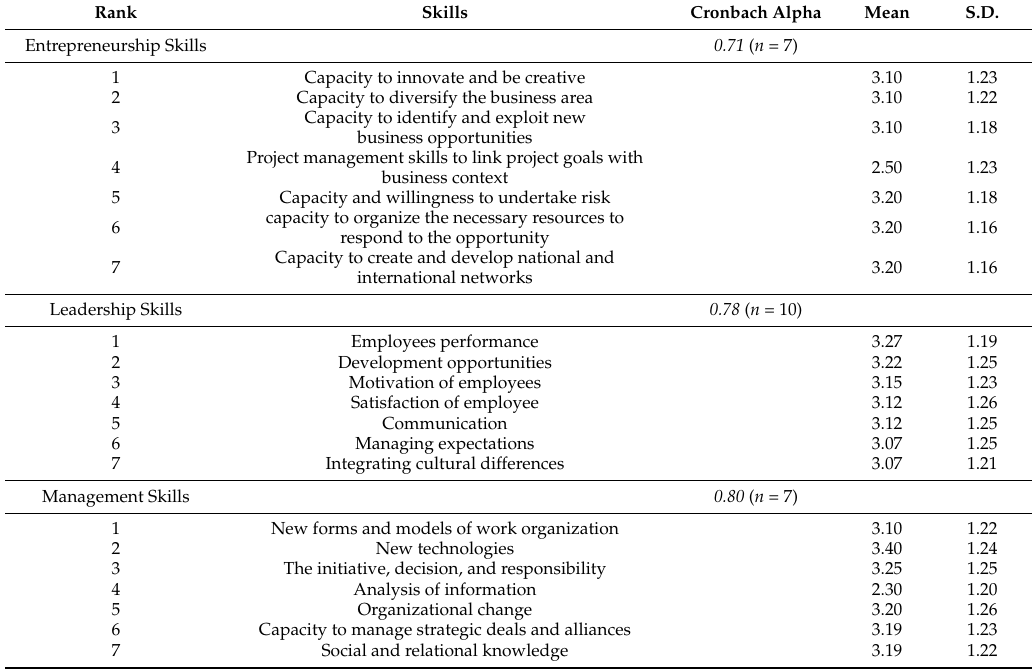
Table 5. Perceived development of skills by the students (1 = no development; 2 = weak development; 3 = moderate development; 4 = considerable development; 5 = strong development)—(Cronbach’s alpha (number of items) Mean (1–5)